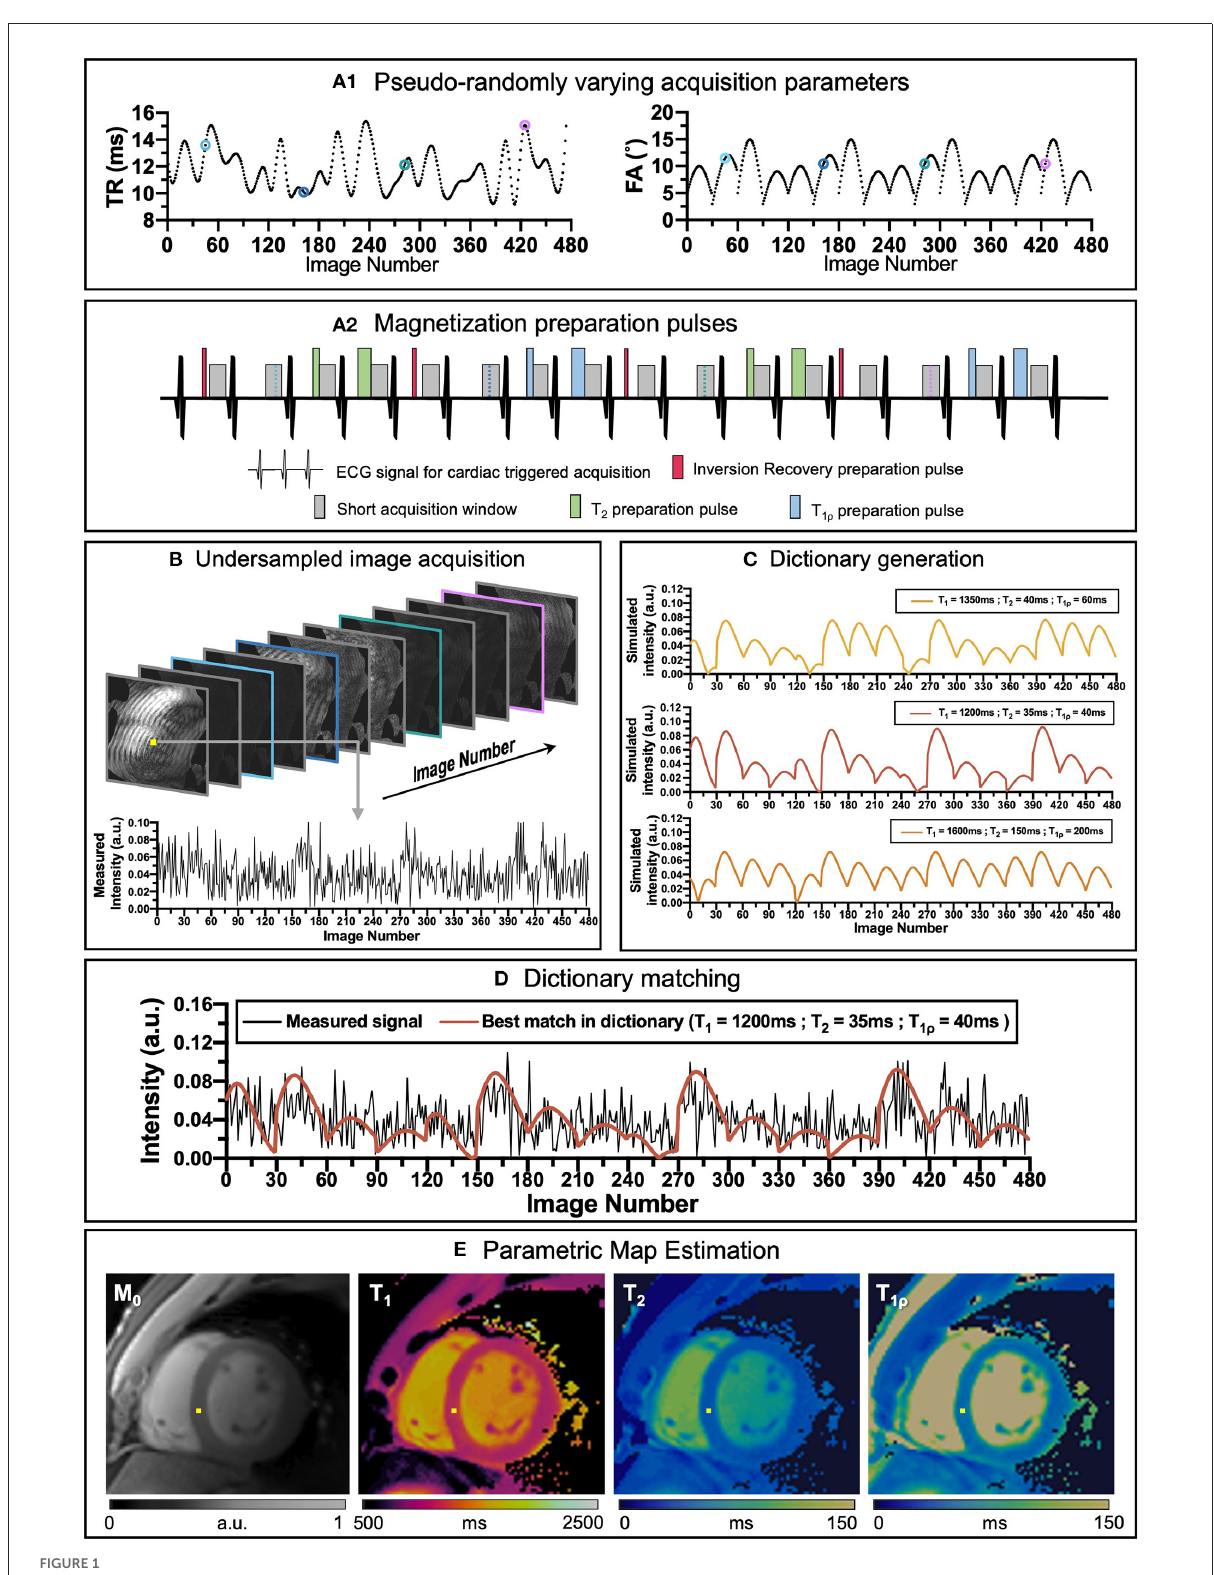
FIGURE1 An overview of cardiac MRF framework. (A1) Repetition time (TR) and variable flip angles (FA) may be pseudo-randomly varied throughout acquisition. (A2) Magnetization preparation pulses are introduced to increment contrast weighing on the desired parameters (in this example Inversion Recovery, (IR pulses, in red), T 2 preparation, (T 2 prep pulses in green) and T 1 ρ preparation, (T 1 ρ prep pulses in blue) are included to